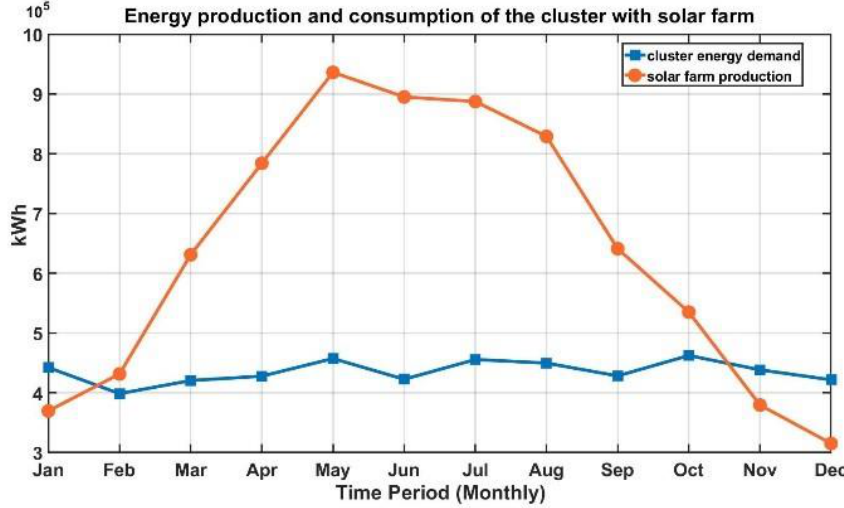
Figure 8. Result of integrating buildings with the solar farm in BCVTB.